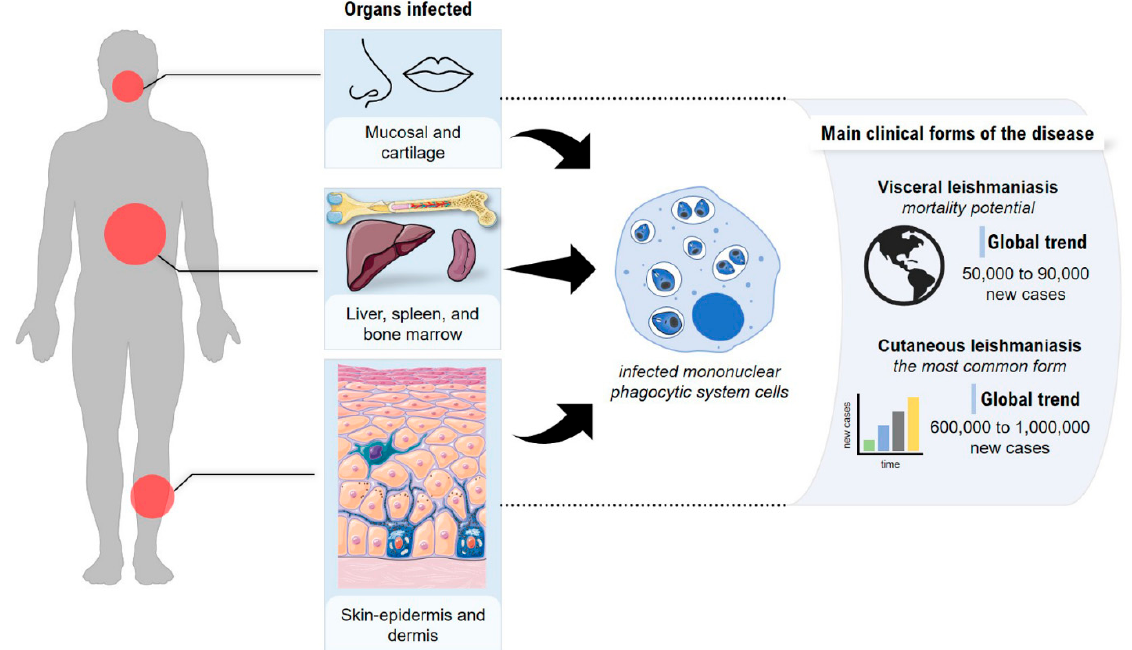
Figure 1. Forms of leishmaniasis and the tissues or organs affected. Visceral leishmaniasis: usually liver, spleen, and bone marrow become infected; cutaneous leishmaniasis: the skin becomes infected.